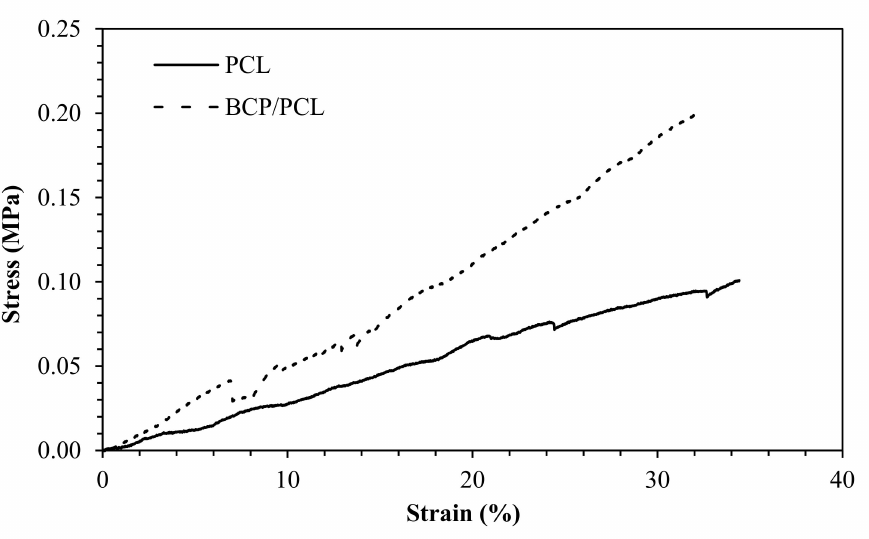
Figure 4. Stress-strain compressive curves of the porous scaffolds: neat PCL (solid line) and BCP/PCL (dotted line)